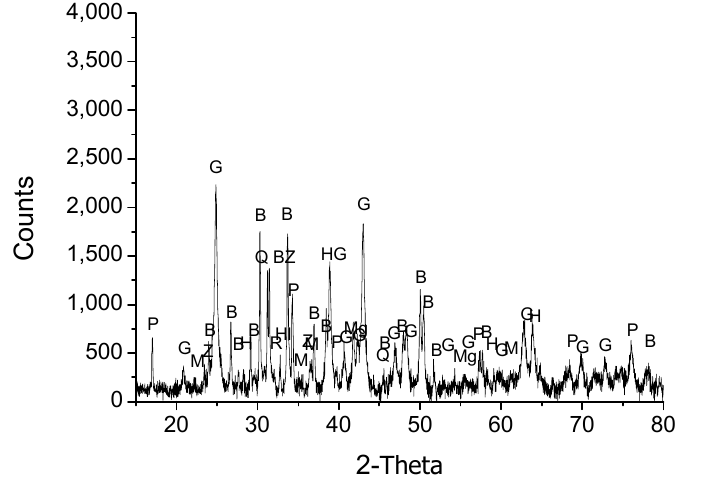
Figure 1. X-Ray di ff raction of the concentrate (H—hematite, M—monazite, B—barite, P—pirochlore, Figure 1. X-Ray diffraction of the concentrate (H—hematite, M—monazite, B—barite, P—pirochlore, G—goethite, Z—zircon, Mg—magnetite, Q—quartz, Table 4. X-Ray fluorescence analysis of the concentrate.